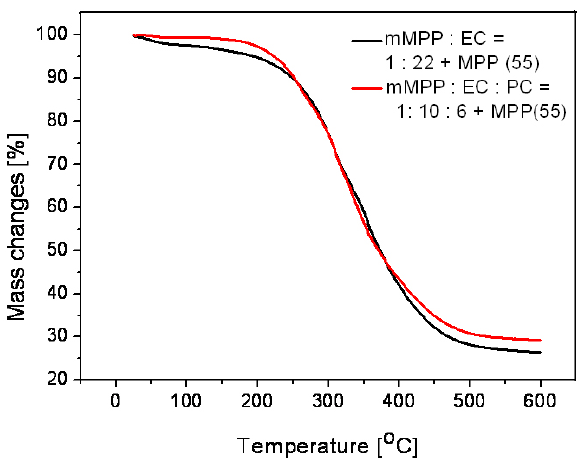
Fig. 9. MMass loss of PUFs measured thermogravimetrically (sam- ple composition is given in insert).